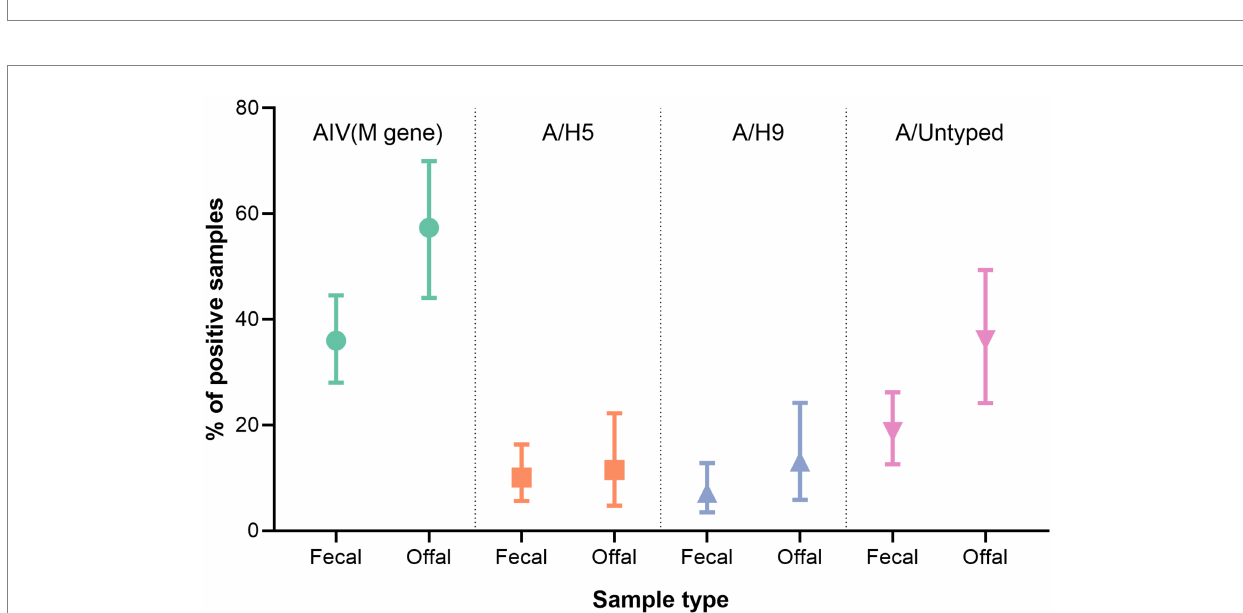
FIGURE 5 Diversity and prevalence of AIV subtypes in collected sample types in the study